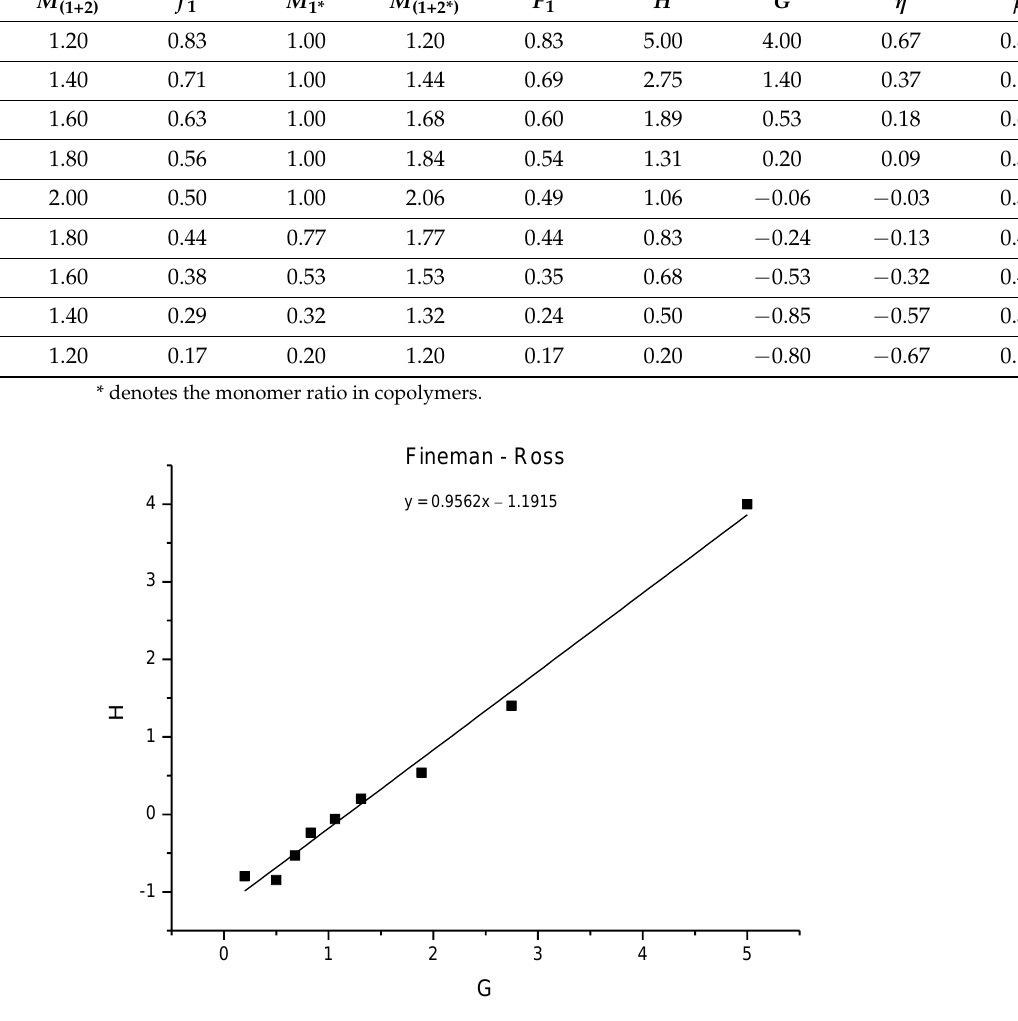
Figure 12. H versus G plot for monomer reactivity calculation; r 1 = 0.9562, r 2 = 1.1915. r 1 = 0.96, r 2 = 1.19, and r 1 × 2 = 1.19. Since the reactivity ratio for ThBr was